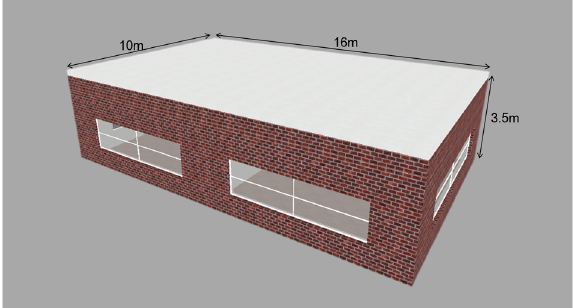
Figure 6. Description of a single-story building.